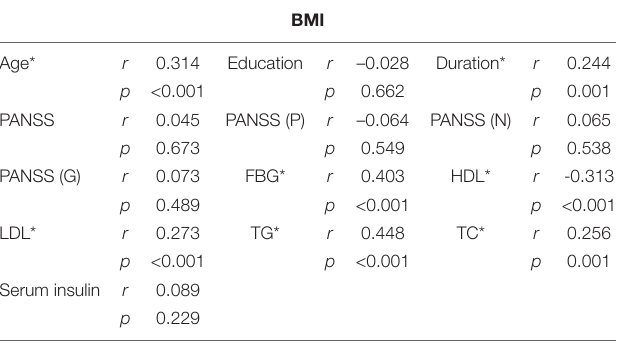
TABLE 2 | Pearson correlation between BMI and various indexes in SC.